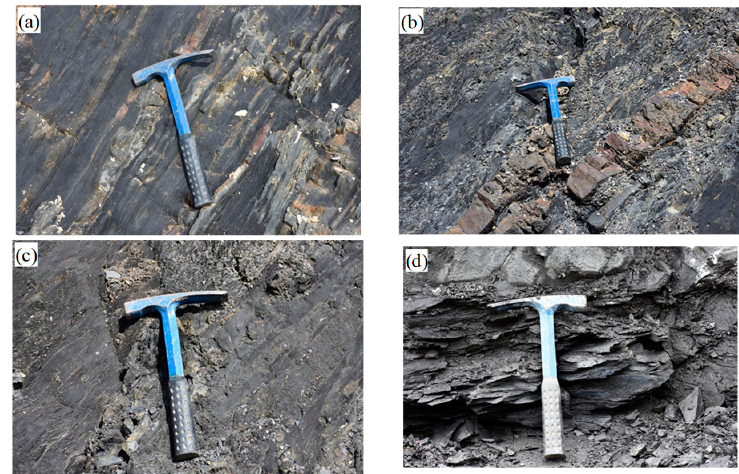
Figure 2. Outcrop view of sedimentary rocks from Zhenning section. ( a ) Dark-gray marlstone intercalated with thin limestone lamina; ( b ) Black mudstone intercalated with brown thin limestone laminae; ( c ) Black thick-layered mudstone with laminated bedding; ( d ) Black thick-layered shale with cross-layer fractures.